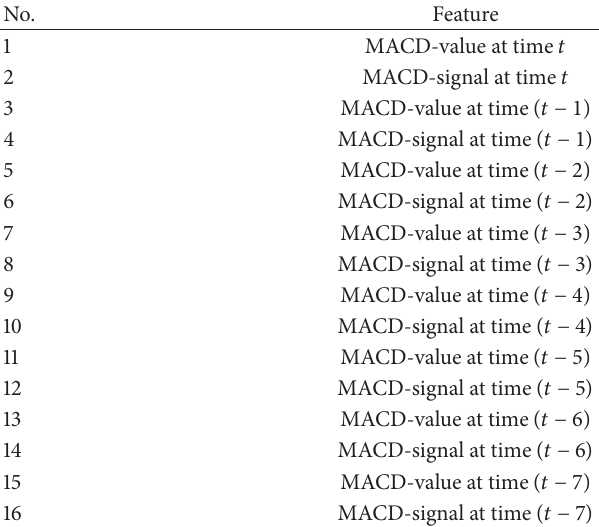
Table 1: Features for each